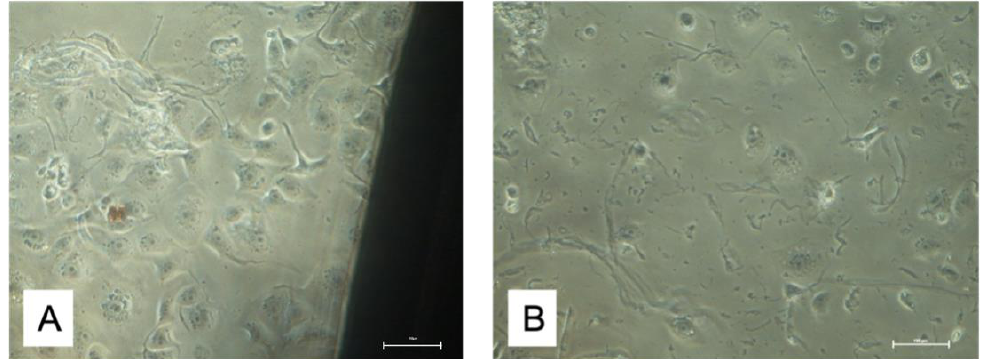
Figure 3. HUKE cell cultures. The imagines were obtained from T1 ( A ) and T2 ( B ) cultures at 24 h.